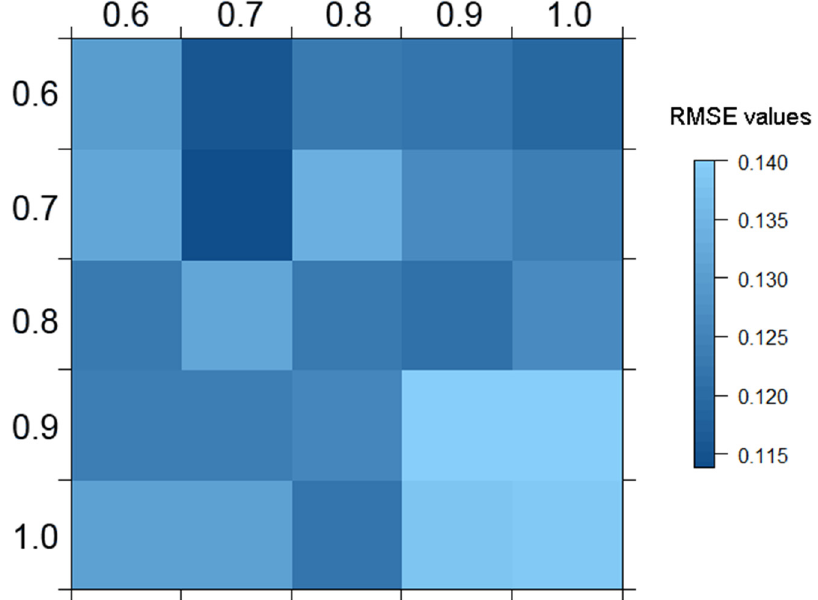
Figure 3. Representation of the performance matrix with the model root mean square error (RMSE) values for each parameter pair. In the x axis are penalization values for the environmental matrix (from 0.6 to 1), and in the y axis those for the biological matrix (also from 0.6 to 1).